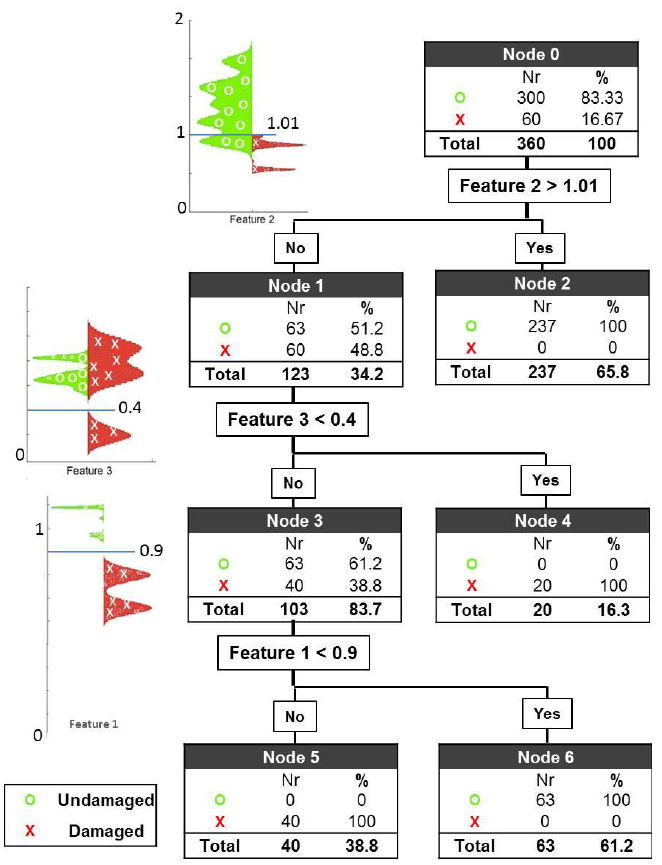
Figure 4. Classification tree. At each node, a threshold based on the features is applied, and the results are represented on the leaves of the